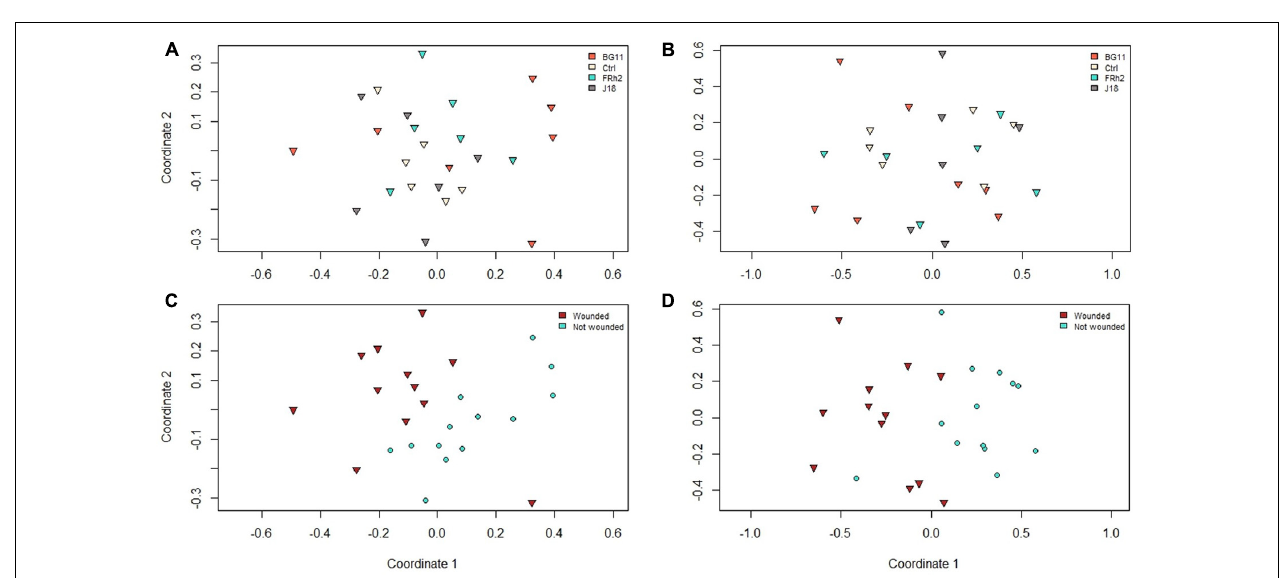
FIGURE 7 | Non-metric multiple dimension scaling (nMDS) plots representing dissimilarities between PCR amplicon profiles from denaturant gradient gel electrophoresis (DGGE) experiments on samples taken from Zea mays (maize) rhizosphere soil DNA, at 30 days after inoculation (DAI), with Beauveria bassiana isolate treatments indicated (see plots legends) for (A) Alphaproteobacteria and (B) Betaproteobacteria, and plant wound treatments indicated for (C) Alphaproteobacteria and (D)